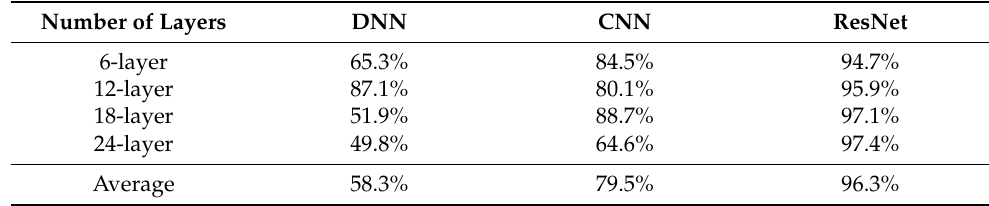
Table 4. Average recognition accuracy of neural